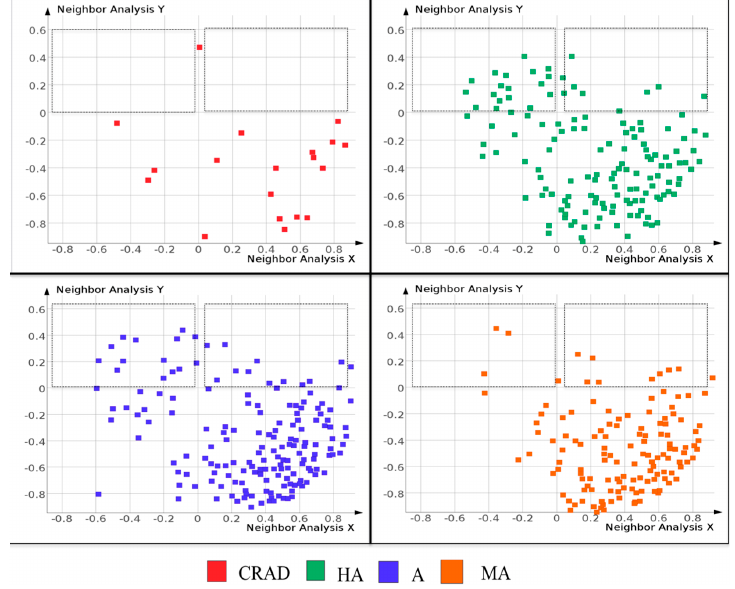
Figure 5. Scaffold structural similarity using Self-Organizing Maps (SOM). Shown above are the self-organizing maps (SOM) of currently registered antimalarial drugs (CRAD) and bioactivity subgroups of natural products with in vitro antiplasmodial activity (NAA): HA-highly active, A-active and MA-moderately active. Markers represent scaffolds that are arranged in a two-dimensional space based on scaffold structural similarity. The individual SOM clearly showed that scaffolds from the NAA (HA, A and MA) occupied distinct regions of the SOM (in the upper quadrants and marked with black rectangles) where scaffolds from CRAD are not found.